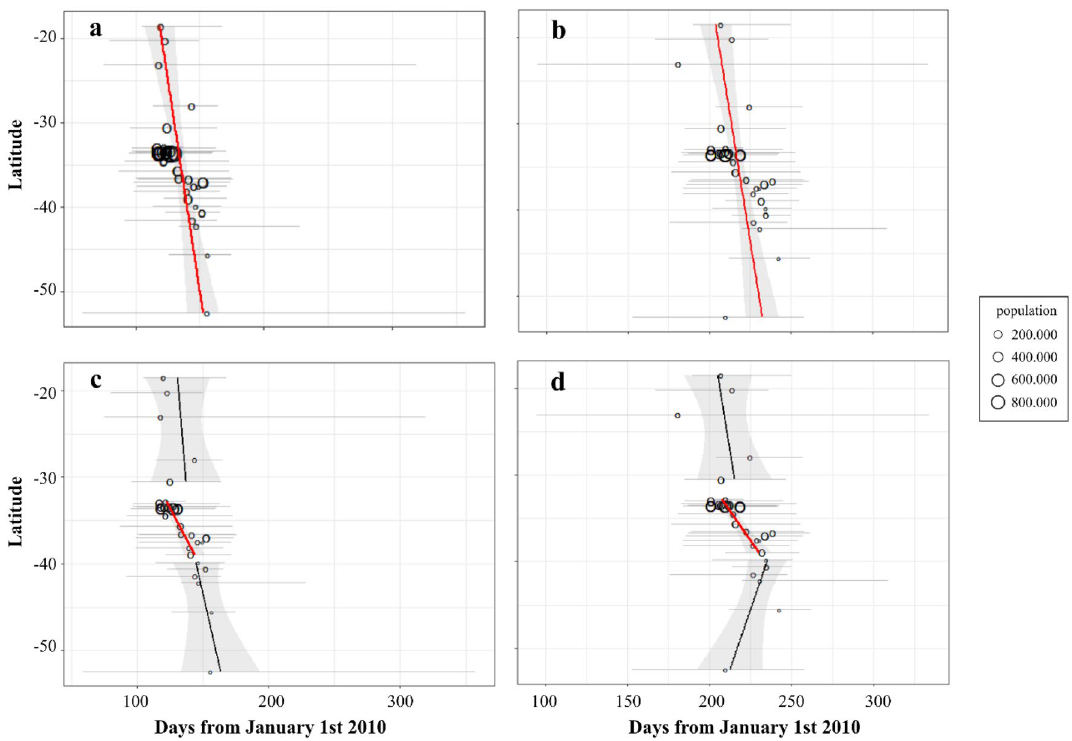
Figure 4. Start and peak of ILI vs latitude, 29 health networks in Chile, 2010–2016. Linear model for start day and peak day vs latitude. ( a) and (b). all health networks; c and d health networks classified by zone: north, center, and south. Red lines: p-value < 0.05, black: p-value > 0.05. Vertical grey zones denote 95% CI, horizontal grey: range of start days for de period for each health network. Black circles size represents population size and black circle position, median start (panels a and c ) or peak day (panels b and d ). ( a ) Linear model for start day versus latitude denotes a slight, but significant north to south gradient: β = 0.99, P = 0.003, R 2 = 0.04. ( b ) Linear model for peak day versus latitude denotes a slight, but significant north to south gradient: β = 0.8, P = 0.002, R 2 = 0.04. ( c ) Linear model for start day versus latitude by zone shows a significant north to south gradient in the center zone of the country. North zone linear regression (top): β = 0.5, P = 0.75, R 2 = 0.003. Center zone linear regression (middle): β = 3.49, P < 0.01, R 2 = 0.09. Southern zone linear regression (bottom): β = 1.49, P = 0.33, R 2 = 0.02. D) Linear model for peak day versus latitude by zone shows a significant north to south gradient in the center zone of the country. North zone linear regression (top): β = 0.8, P = 0.554, R 2 = 0.01. Center zone linear regression (middle): β = 3.65, P < 0.01, R2 = 0.11. Southern zone linear regression (bottom): β = − 1.8, P = 0.08, R 2 = 0.05 24,27 .